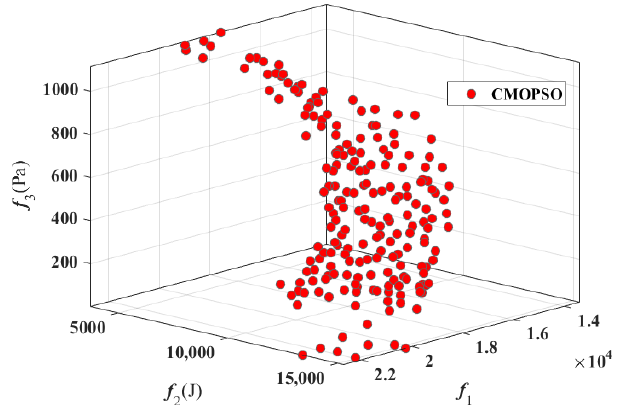
Figure 10. Pareto optimal solution distribution.